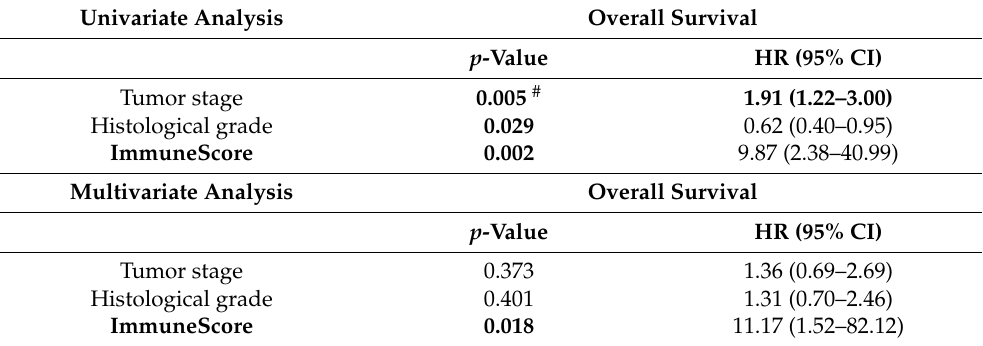
Table 3. Univariate and multivariate Cox regression models evaluating the tumor stage, the histologi- cal grade and the IS and the